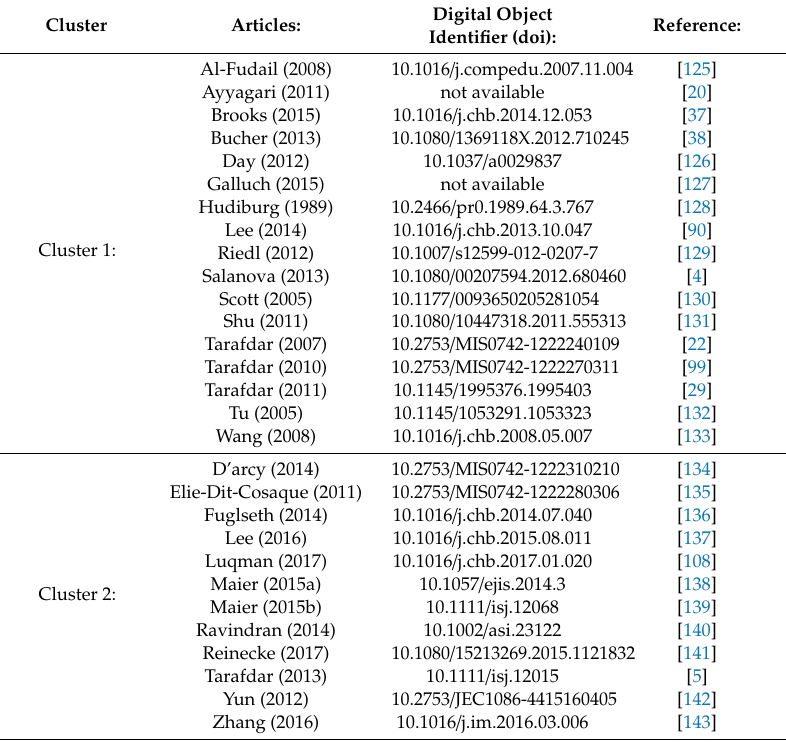
Table A1. Complete reference list identified as bibliographic